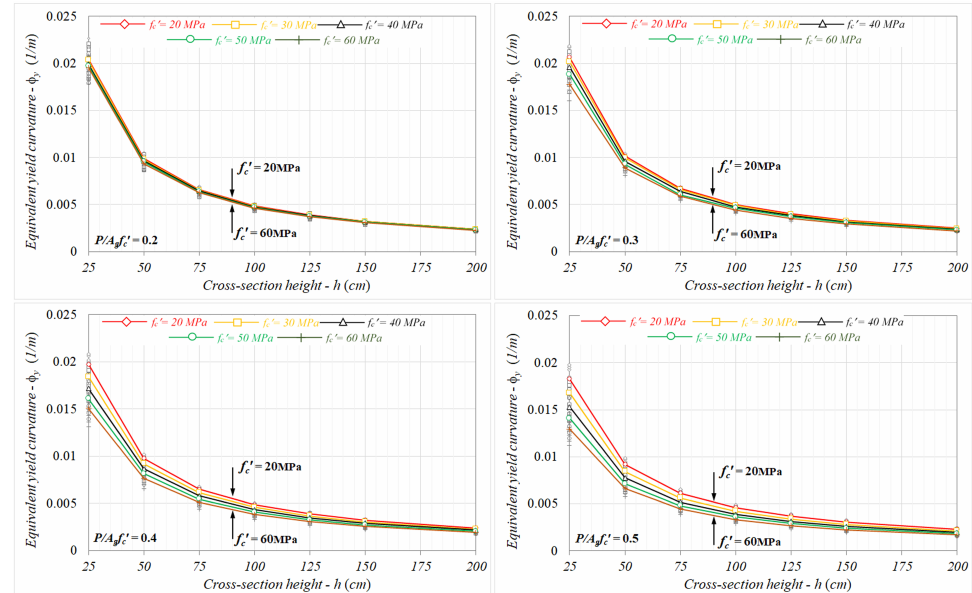
Figure 6. The variations of equivalent yield curvatures with the cross-section height in terms of di ff erent ( a ) axial load levels, ( b ) reinforcement ratios, and ( c ) concrete compressive